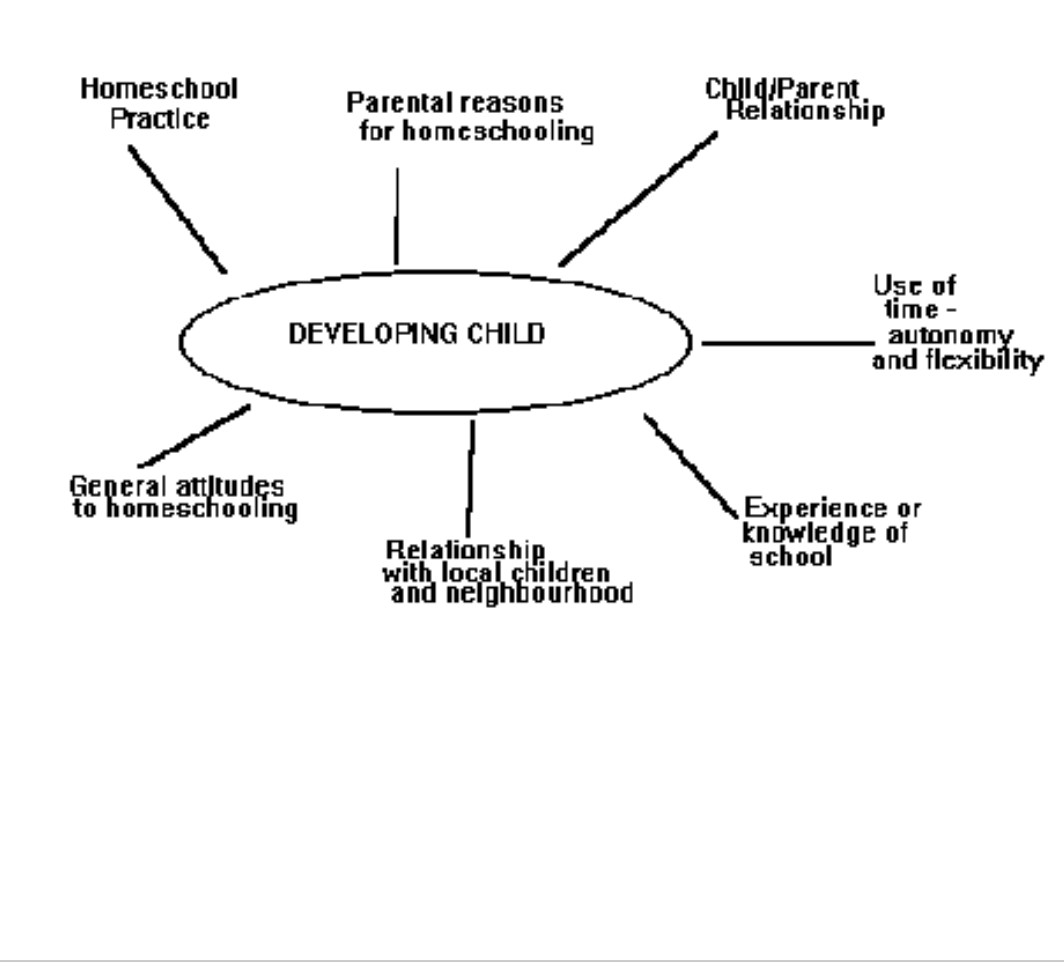
Figure 1: Model of factors affecting children's perceptions of